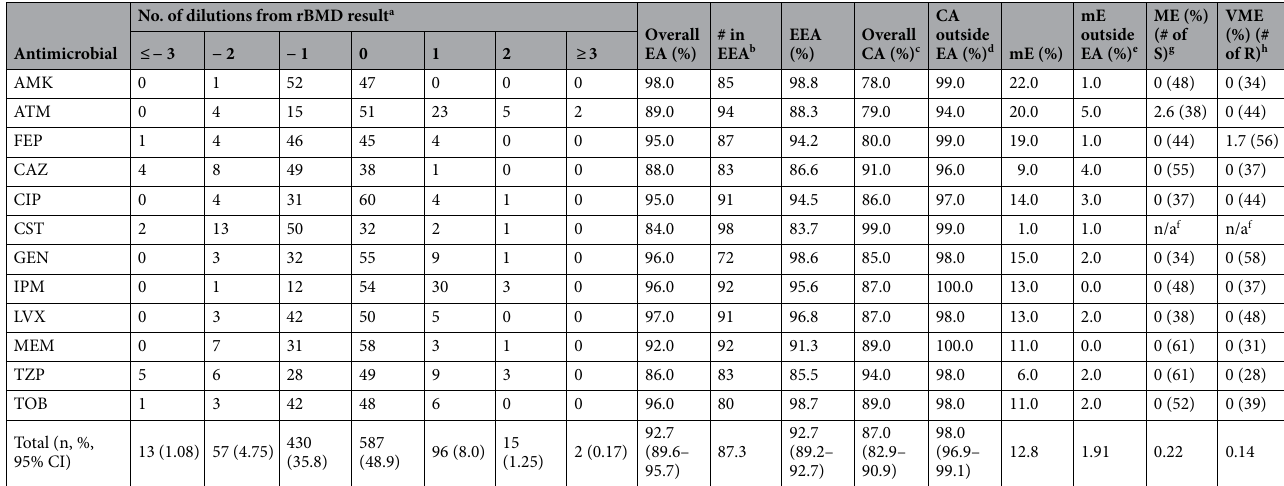
Table 3. Difference in MICs between D300e and rBMD panels for P. aeruginosa isolates. a The total number of D300e MICs (on- and off-scale) that were compared to equivalent rBMD MIC. b Calculated using the evaluable on-scale MICs that were within 1log2 dilution between D300e and rBMD dispensed panels. c Agreement of S,I,R categories between D300e and rBMD panels determined using CLSI 2020 criteria among 1,200 MIC measurements per method. d Calculated by identifying the number of strains where CA differences are ≥ ± 2log 2 dilutions from the corresponding rBMD MIC. e Calculated by identifying the number of minor errors in strains where D300e and rBMD MICs were ≥ ± 2log 2 dilutions apart. f There are only I or R breakpoints provided for CST by CLSI 3 . g The number of susceptible isolates was used as the denominator in the calculation of ME. h The number of resistant isolates was used as the denominator in the calculation of